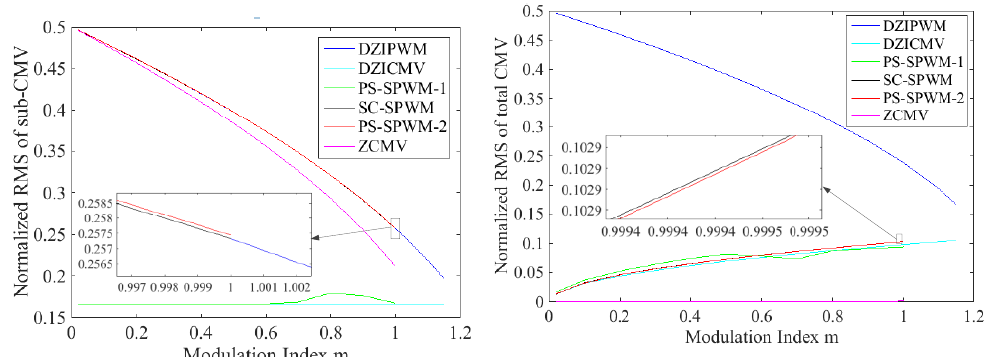
Figure 18. Normalized RMS value of CMV in simulation ( left ) sub-CMV ( right ) total CMV.